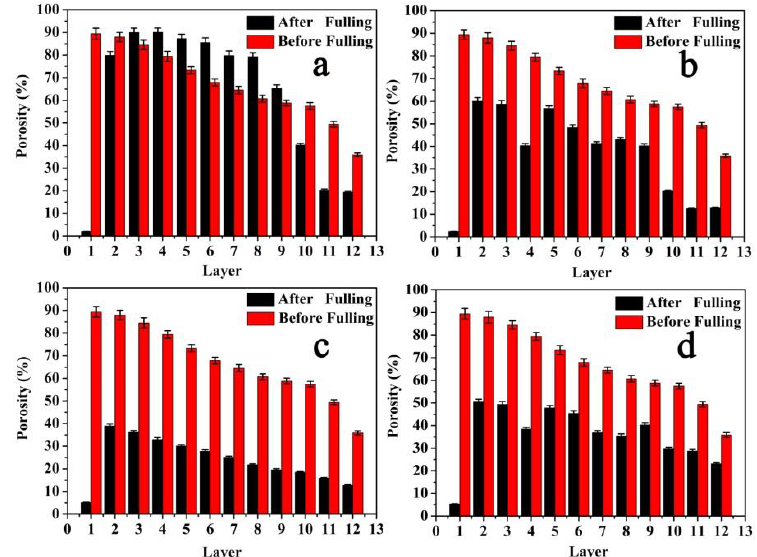
Figure 5. Filling rates of PGG in different solvent mixtures. ( a ) ethanol/water at 0:1; ( b ) ethanol/water at 3:1; ( c ) ethanol/water at 9:1; ( d ) acetone/water at 3:1. SD 0.3, n = 3.